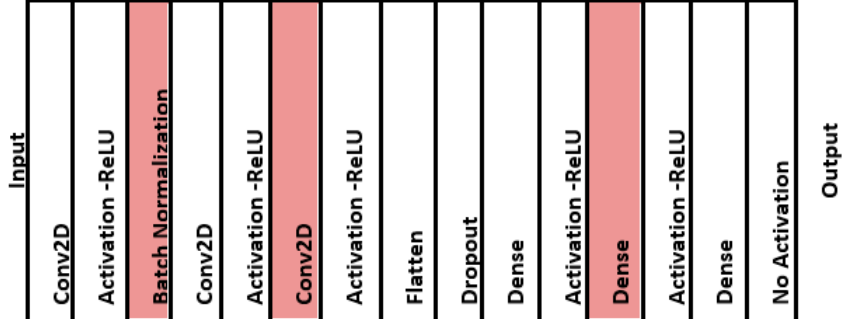
Figure 7. Batch normalization with mean and variance.